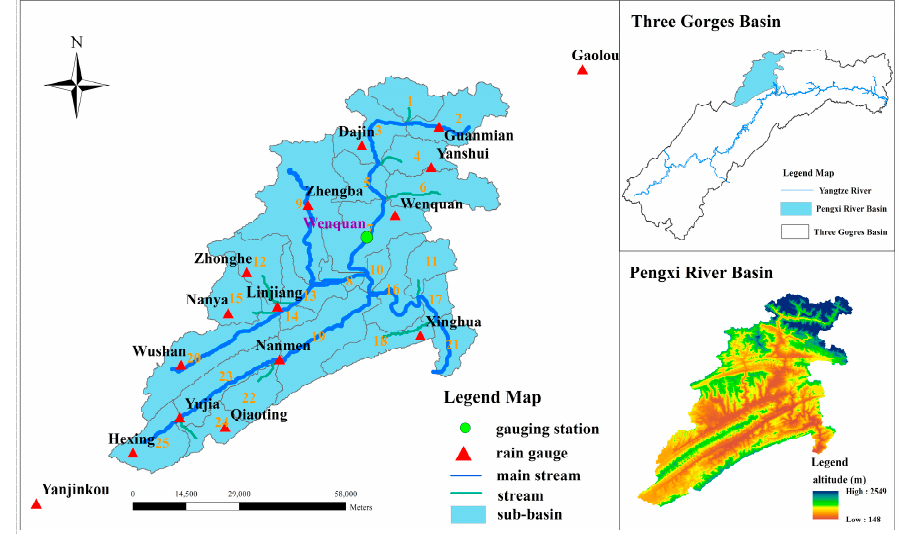
Figure 1. Location of gauging station (green solid circle), rain gauges (red solid triangle), and topography in the Pengxi River basin.